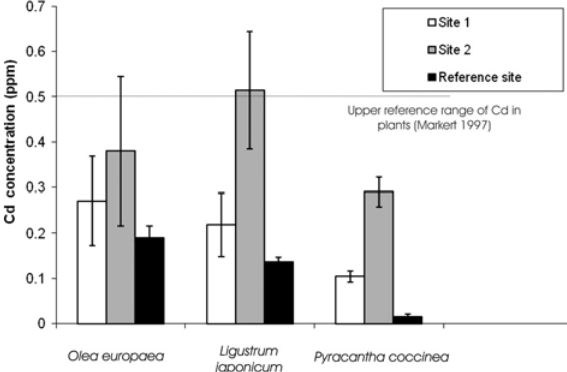
Fig. 2. Cadmium concentrations (ppm dry wt) in the leaves of Olea europaea , Ligustrum japonicum, and Pyracantha coccinea from different studied sites (site 1: industry; site 2: traffic; reference site: botanical garden)